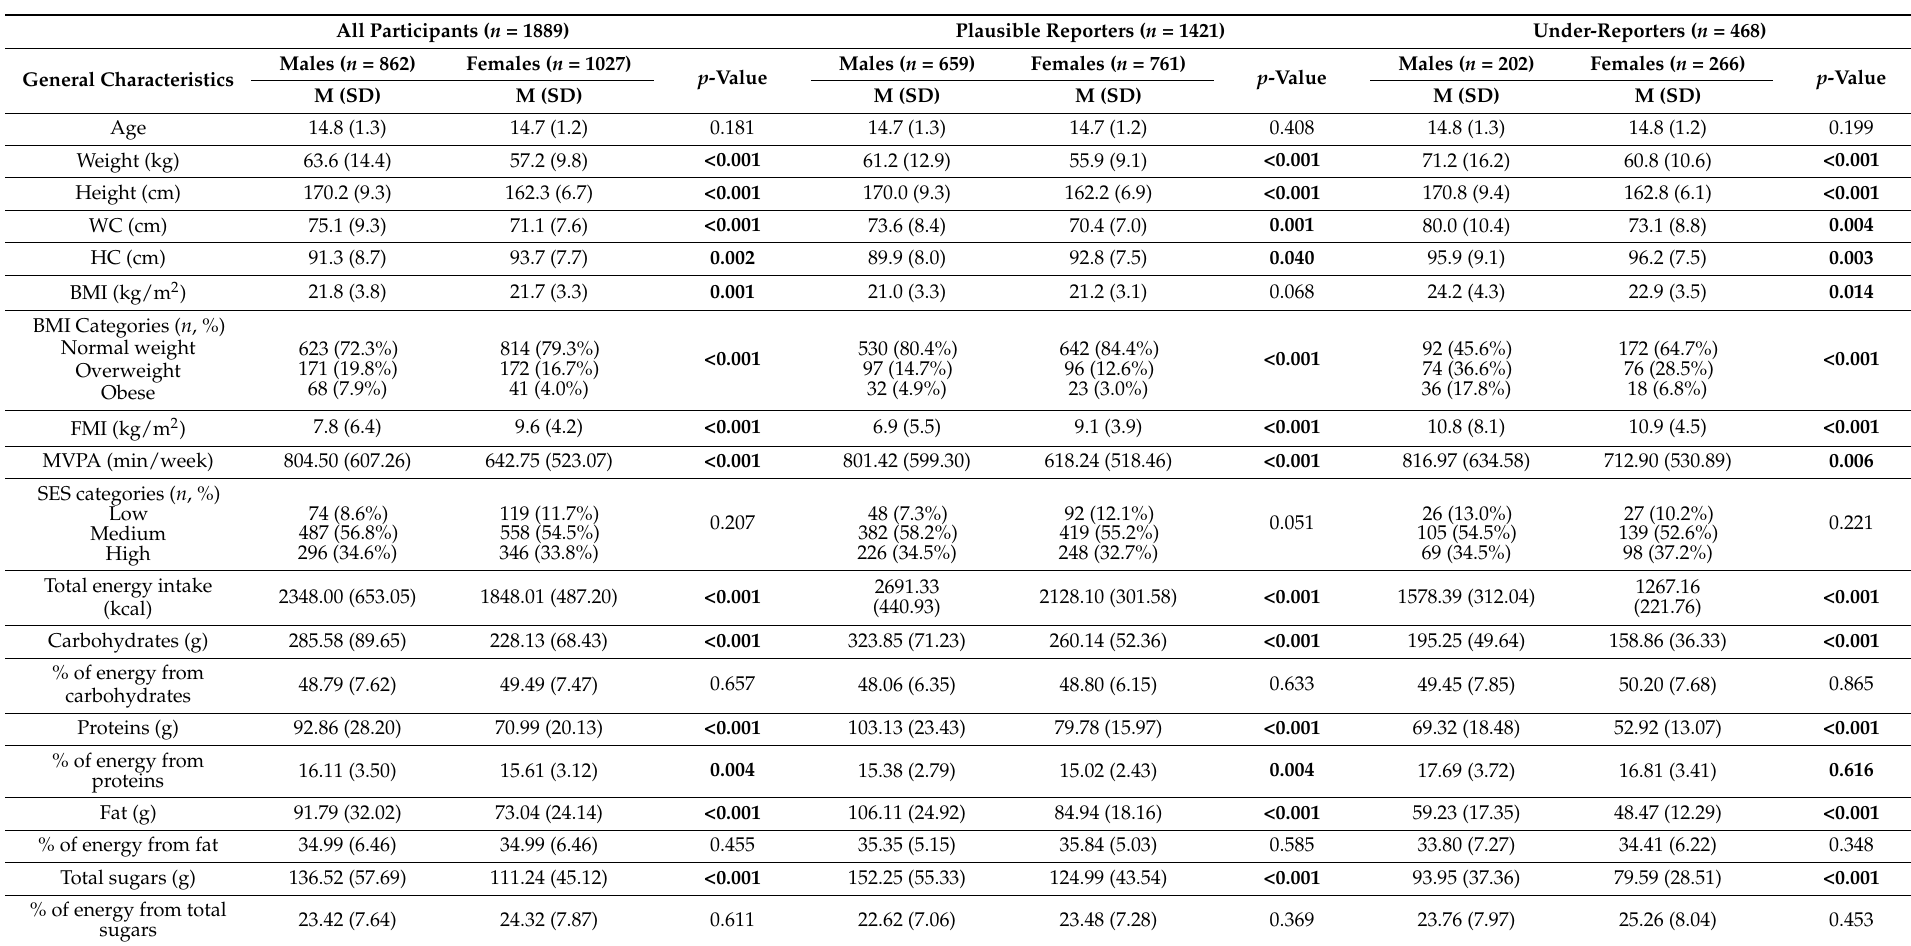
Table 1. Characteristics of all participants, plausible reporters, and under-reporters in study sample and mean daily intake of energy and macronutrient. Differences of mean values by gender were considered using Student’s t -test